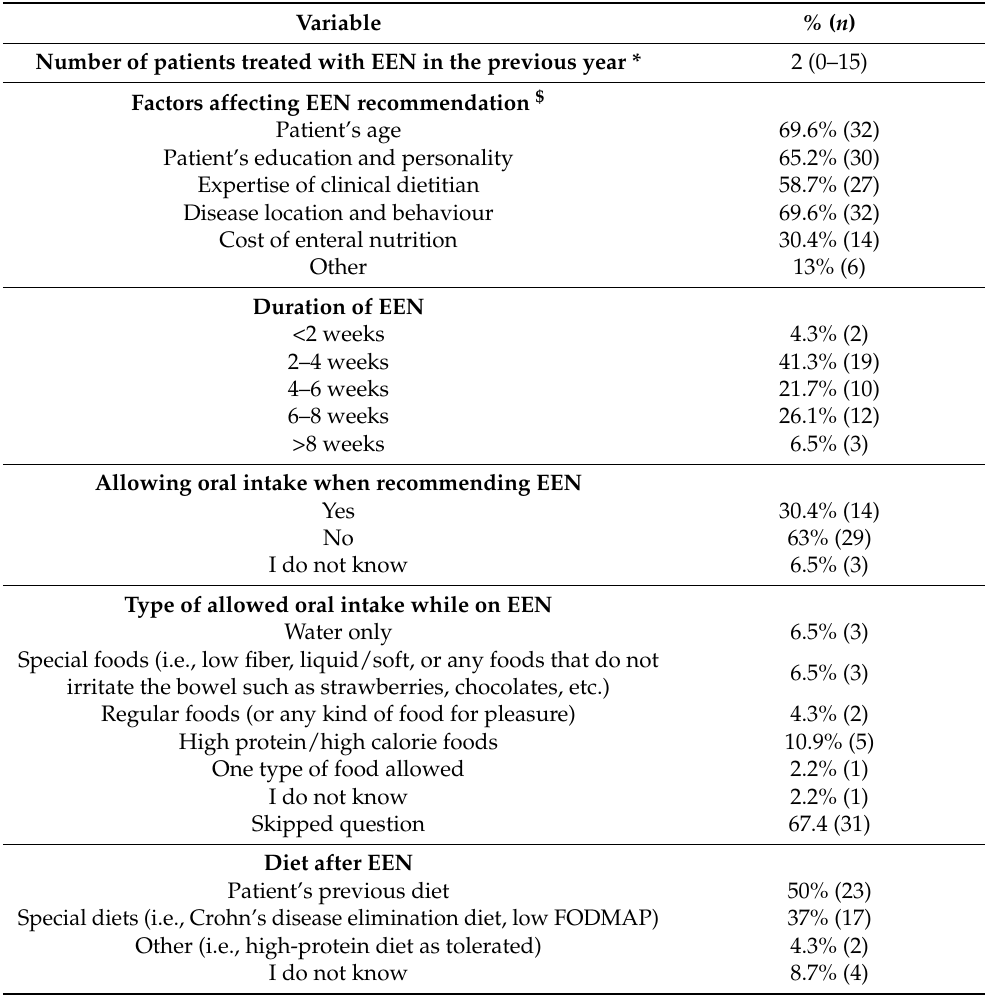
Table 2. EEN practices and protocol characteristics ( n =